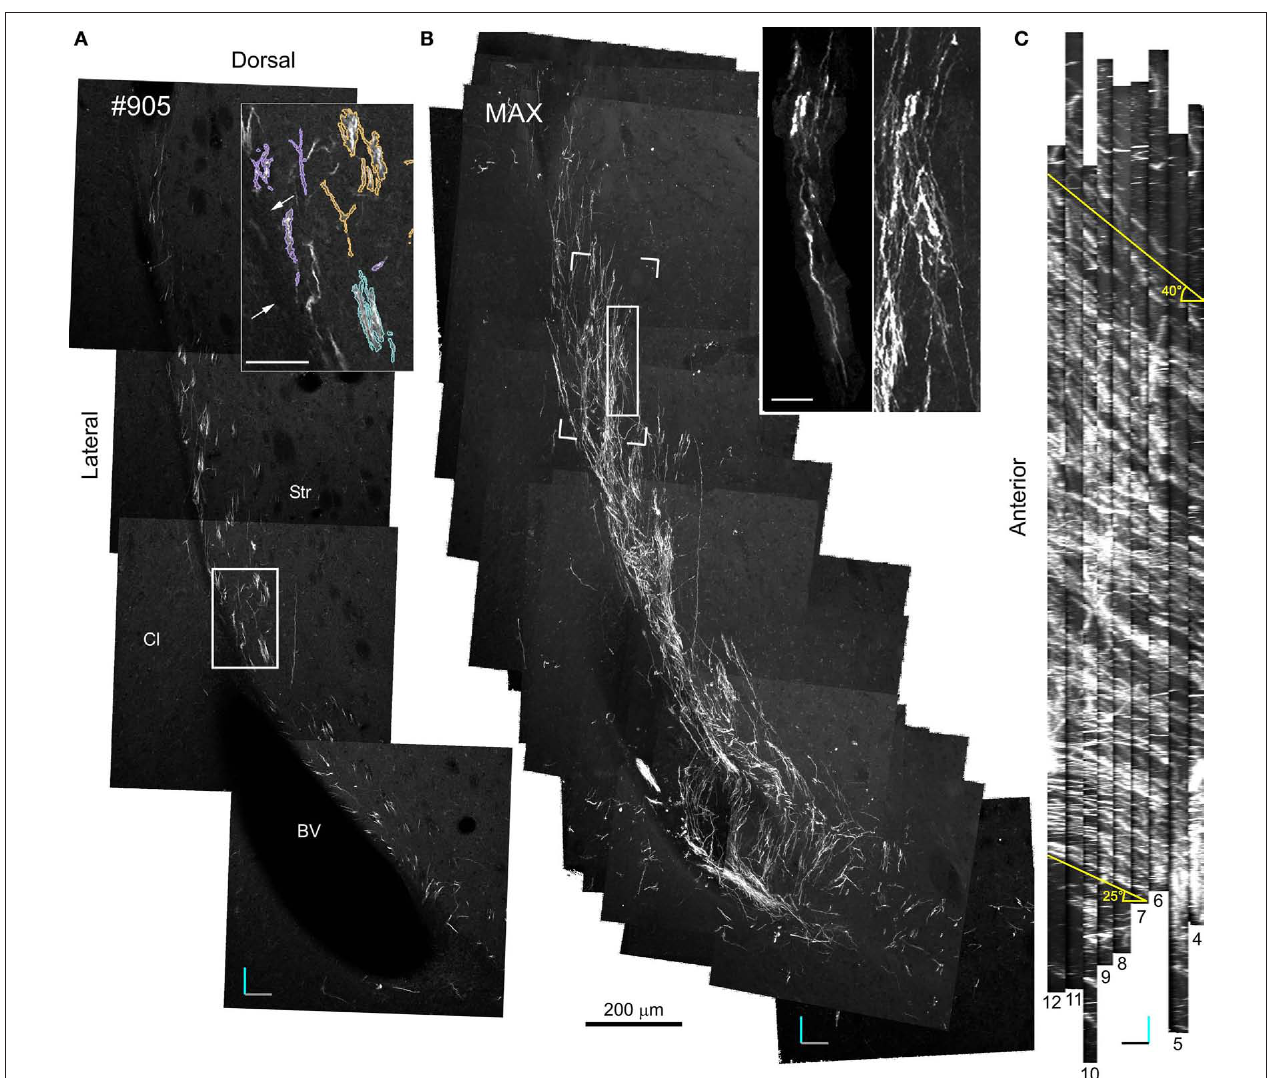
a continuous line in the main image, on the left a DCX + cell in a fascicle (the pink fascicle of Figures 5 and 7 ) within the same area after a manual cut-off of the unwanted parts section by section. The open box indicates the position of the reconstruction shown in Figures 6 and 7 . (C) MIP along the y -axis, note the numerous parallel fascicles of DCX + processes. The slope of these fascicles on the rostro-caudal axis is indicated. Orientation Bars: gray line: medial; cyan line: dorsal; dark line: rostral; Scale bars: 50 μm in the inset in A; 25 μm in the inset in